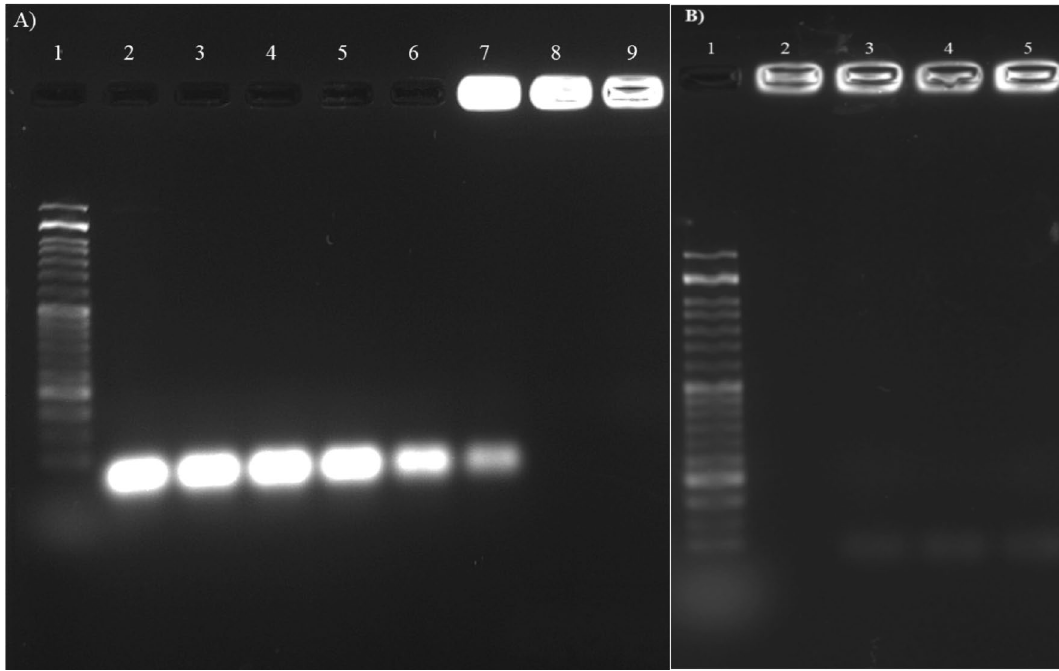
Figure 3. Gel electrophoresis retardation assay of ( A ) siRNA@[FA-PEGylated/PEI@GuIL@KIT-6] complex with different proportions (Lane 1): Marker (50 bp), (Lane 2): siRNA, (Lane 3): (1:1), (Lane 4): (1:2), (Lane 5): (1:6), (Lane 6): (1:12), (Lane 7): (1:25), (Lane 8): (1:35), (Lane 9): (1:50). All proportions are according to (siRNA: [FA-PEGylated/PEI@GuIL@KIT-6]). ( B ) siRNA@[FA-PEGylated/PEI@GuIL@KIT-6] with various pore sizes. (Lane 1): Ladder (50 bp), (Lane 2): Nanocarrier MSNp = 2.5, (Lane 3): Nanocarrier MSNp = 3.5, (Lane 4): Nanocarrier MSNp = 6.5 and (Lane 5): Nanocarrier MSNp =